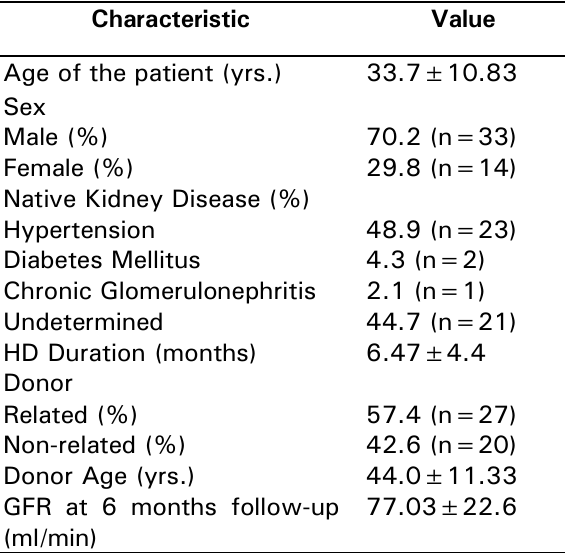
Table.1. Recipient and donor characteristics